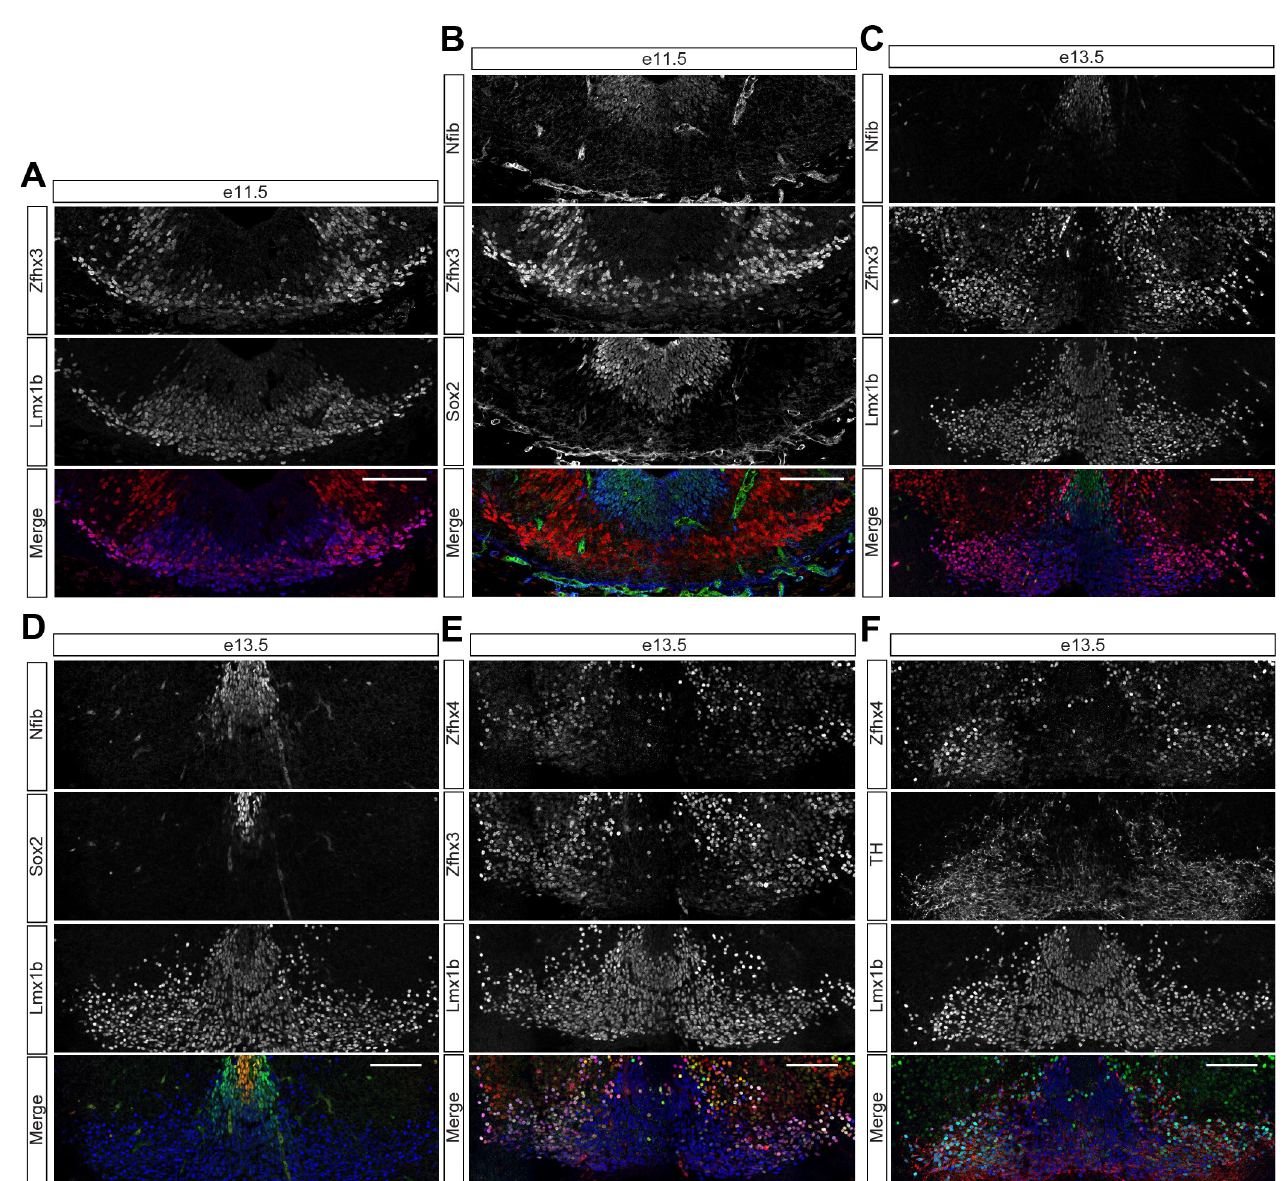
Fig 3. Midbrain dopaminergic neurons are a temporal population of neurons derived from the midbrain floor plate (see also S10 Fig). (A) Coexpression of Zfhx3 and Lmx1b in neurons derived from the midbrain floor plate at e11.5. (B) Nfib is restricted to Sox2-positive neural progenitors in the ventral midbrain at e11.5. (C) Mutually exclusive expression of Zfhx3 and Nfib in Lmx1b-positive neurons at e13.5. (D) Nfib labels Lmx1b-positive neurons directly adjacent to Sox2-positive progenitors at e13.5. (E) Colocalization between Zfhx3 and Zfhx4 in Lmx1b-positive neurons at e13.5. (F) Zfhx4 labels Lmx1b- positive neurons expressing high levels of TH at e13.5. Scale bars = 100 μ m. TH, Tyrosine hydroxylase.